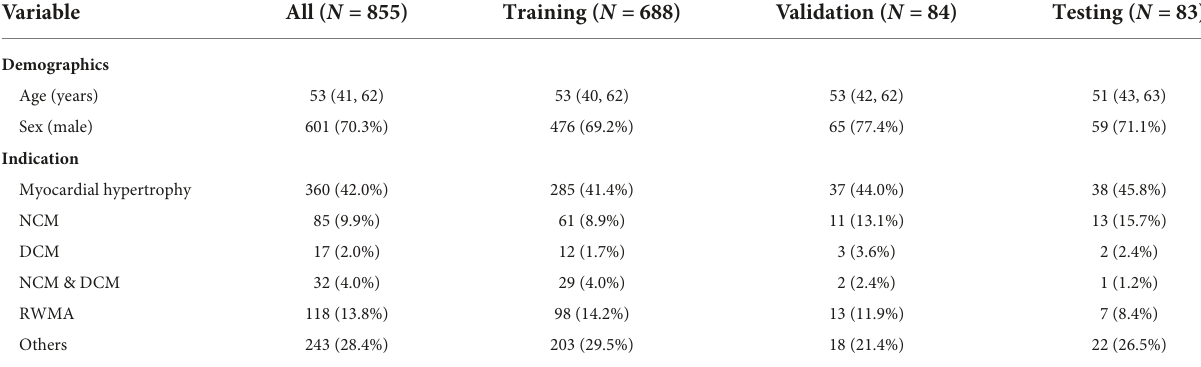
TABLE 1 Baseline characteristics.